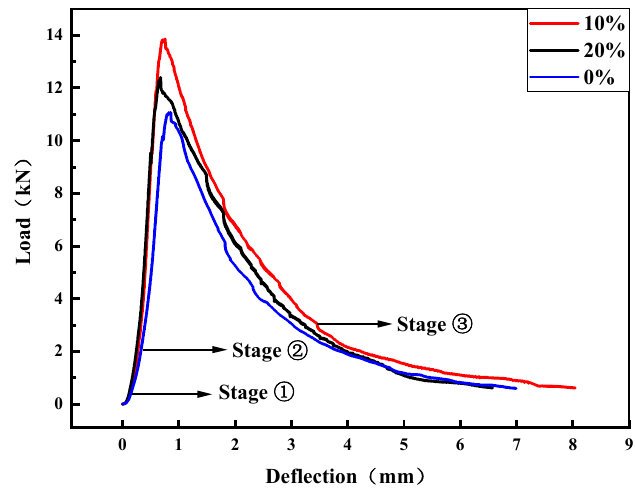
Figure 15. Load deflection curve.